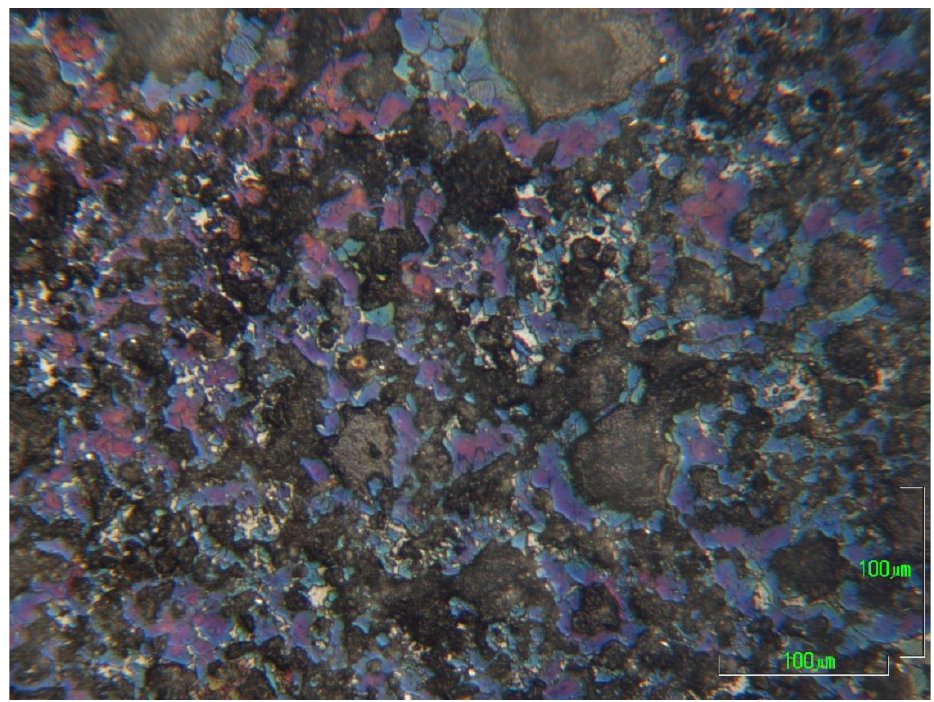
Figure 10. Image of optical microscopy of P1 65A_1340 .